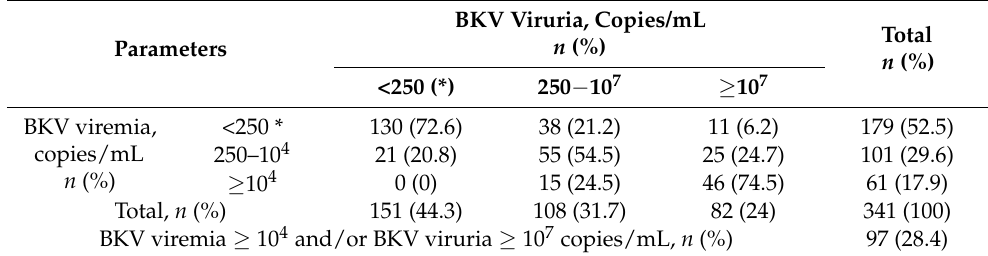
Table 4. Characteristics of BKV virus load in serum and urine according to immunosuppressive strategies. Parameters Genotypes BKV genotypes, n (%)